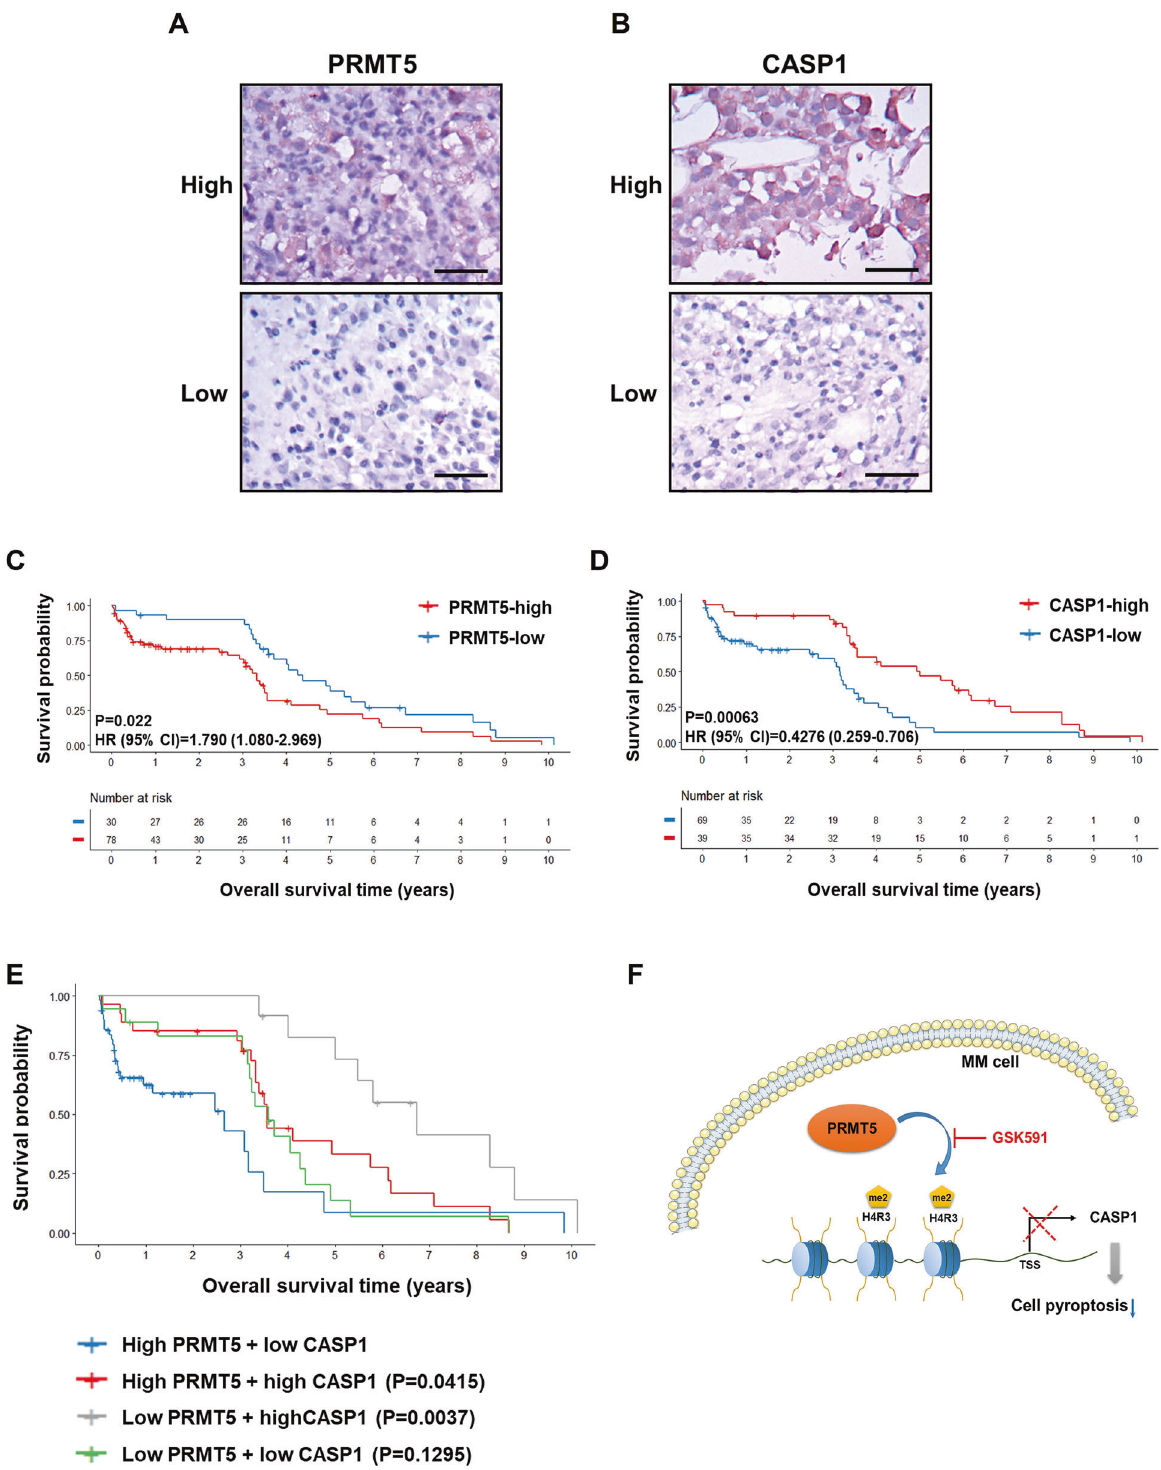
Fig. 6 High expression of PRMT5 and low expression of CASP1 associate with poor clinical outcomes in MM patients. A , B Representative images of IHC staining of PRMT5 and CASP1 in MM bone marrow tissues, which were divided into a high-expression group (upper panel) and a low-expression group (lower panel). Scale bar = 50 μ m. C Overall survival of high PRMT5 ( n = 78) and low PRMT5 ( n = 30) MM patients performed by Kaplan-Meier survival analysis. D Overall survival of high CASP1 ( n = 39) and low CASP1 ( n = 69) MM patients performed by Kaplan-Meier survival analysis. E Kaplan-Meier survival analysis of MM patients based on both PRMT5 and CASP1 expression. MM patients were divided into four groups: high PRMT5 and low CASP1 expression ( n = 51), high PRMT5 and high CASP1 expression ( n = 27), low PRMT5 and high CASP1 expression ( n = 12), and low PRMT5 and low CASP1 expression ( n = 18). P -values were calculated using the group of high PRMT5 and low CASP1 expression as the reference group. F A model for PRMT5-dependent cell proliferation and apoptosis by silencing CASP1 in